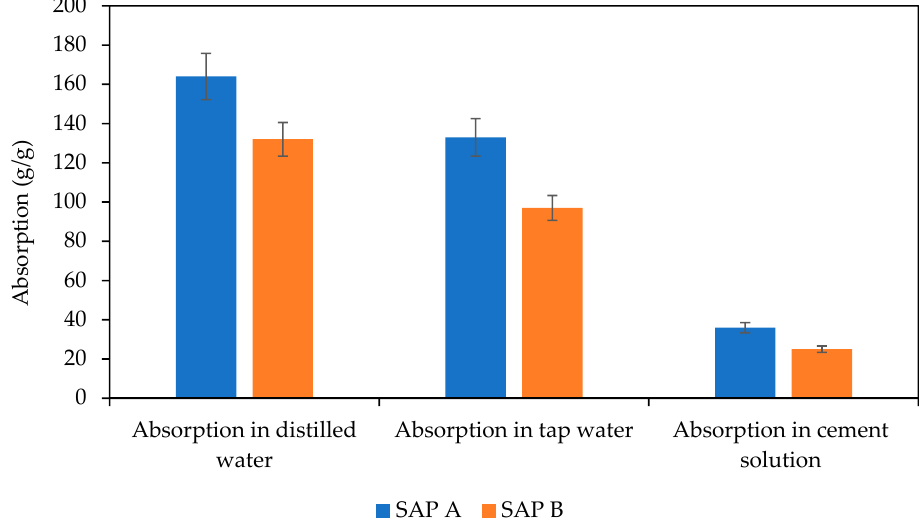
Figure 1. Absorption characteristics of studied SAPs.